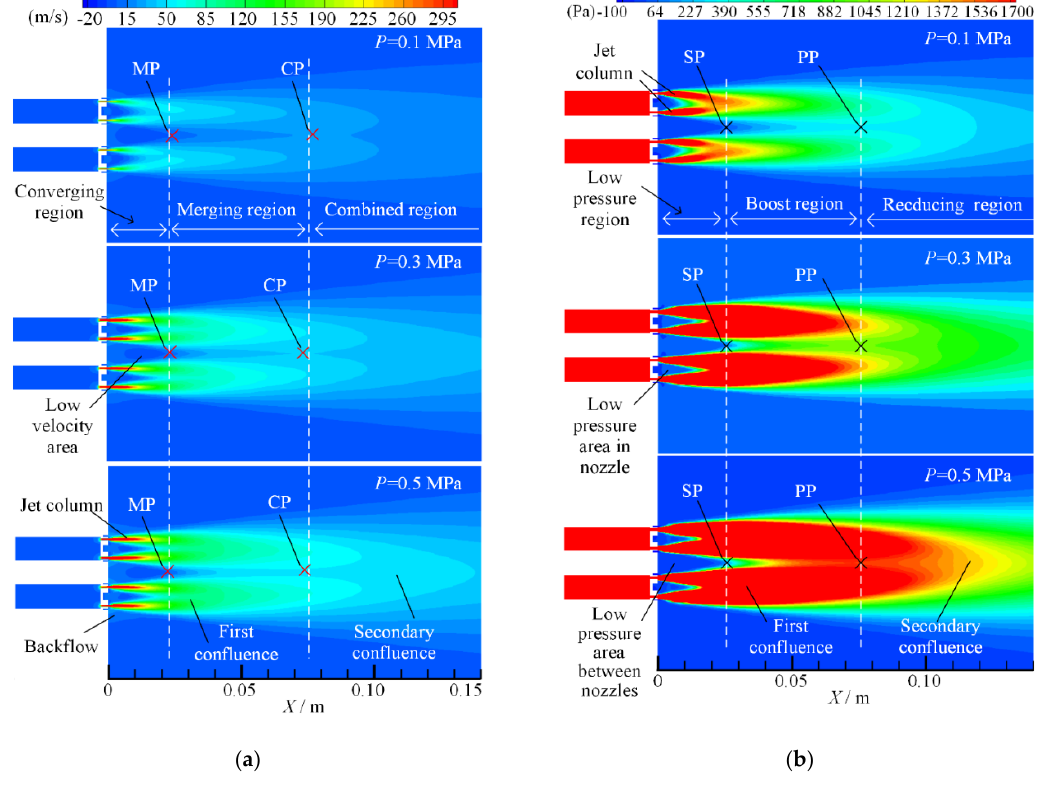
Figure 8. Symmetry plane 2 velocity contours with different inlet pressures:( a ) velocity contour; ( b ) pressure contour.